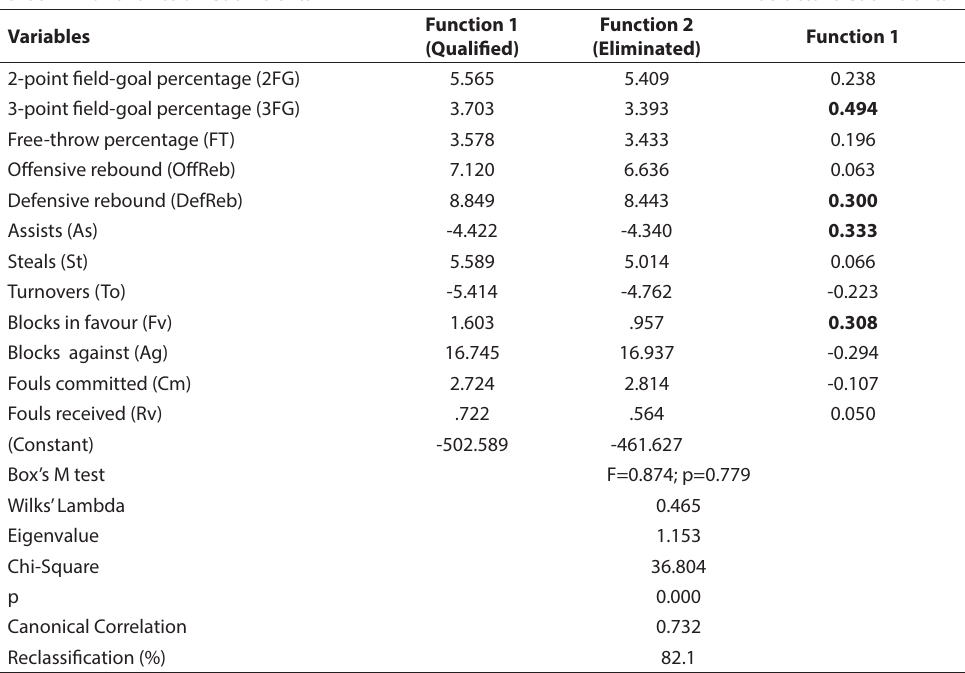
TABLE 3 Discriminant analysis results for